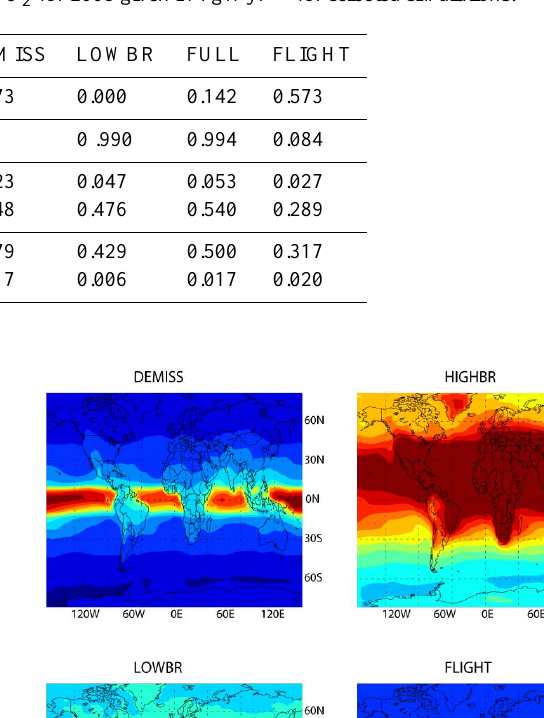
Table 3. The annual tropospheric chemical budget terms for CH 3 ONO 2 for 2008 given in TgNyr − 1 for selected simulations.